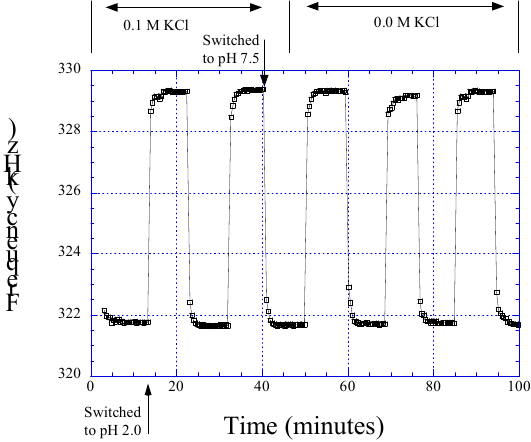
Figure 15a. Cross-correlation between two functionalized magnetoelastic sensors enables pH measurement independently of solution salt concentration.